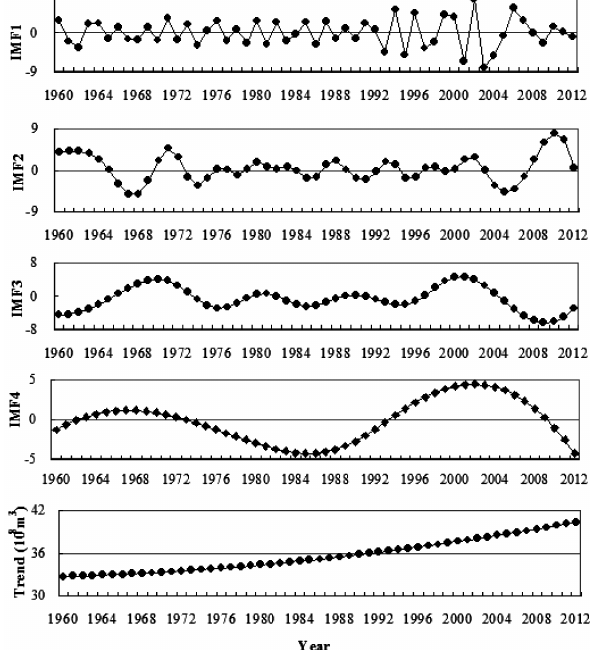
Figure 7. The EEMD results for the time series of AR in the Kaidu River.